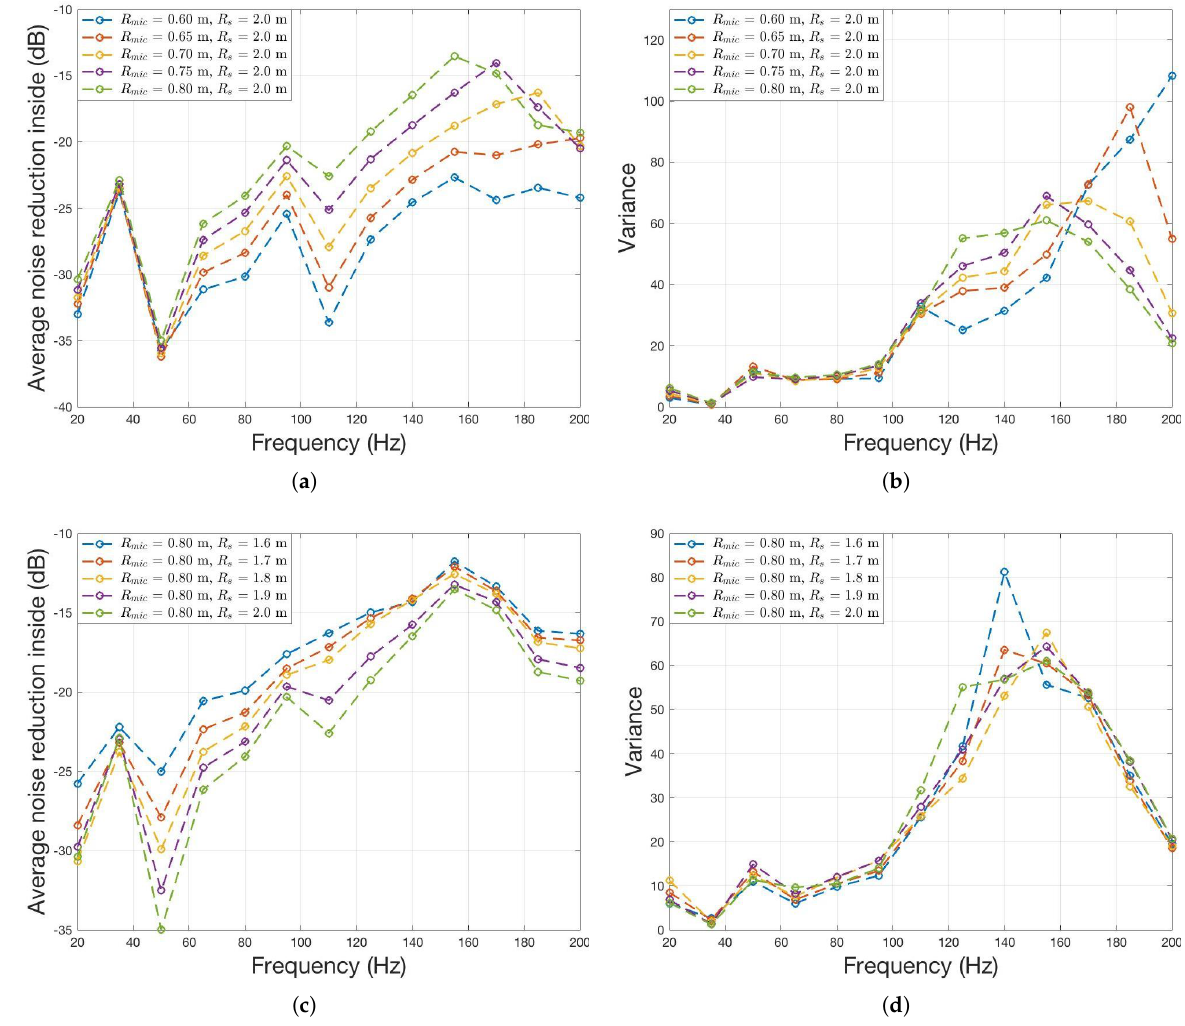
Figure 7. Average noise reduction and variance with respect to frequency at different radii of microphones and loudspeaker arrays. ( a , c ) Average noise reduction. ( b , d )